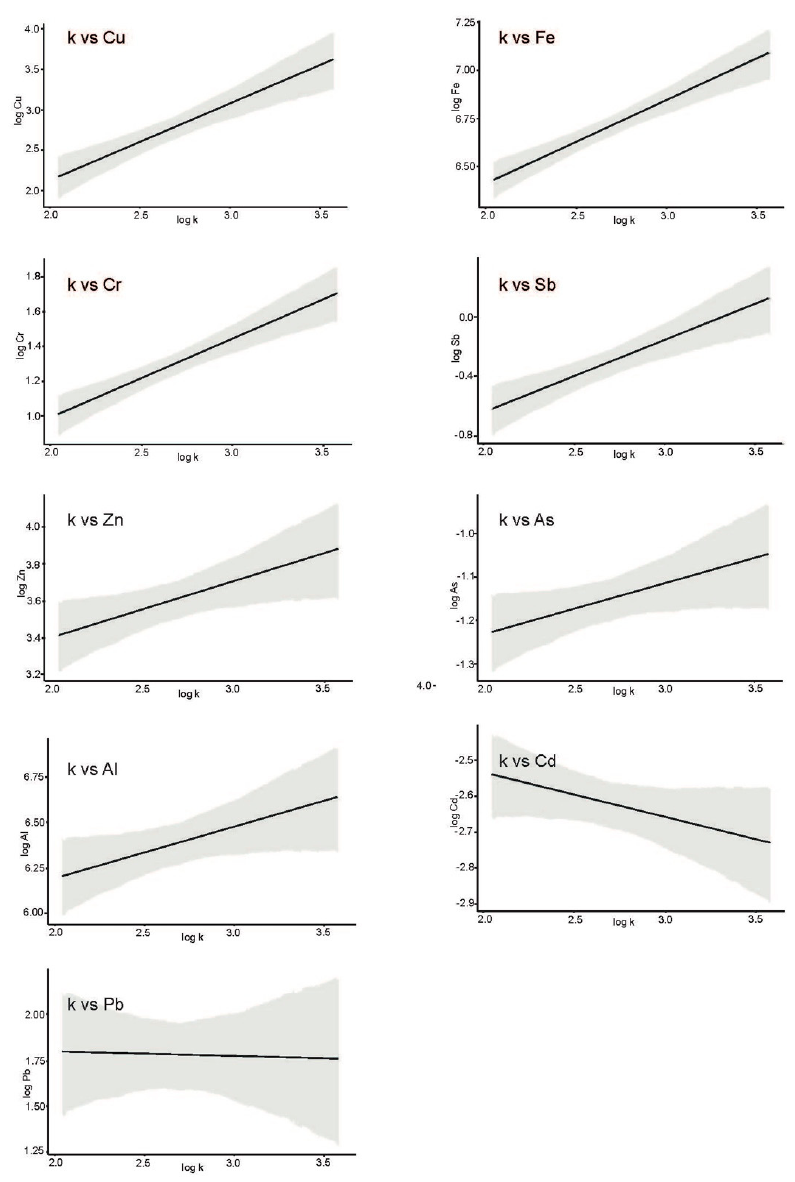
Figure 7. Relationships between magnetic susceptibility and element concentrations, along with the 95% credible intervals of the regression line.